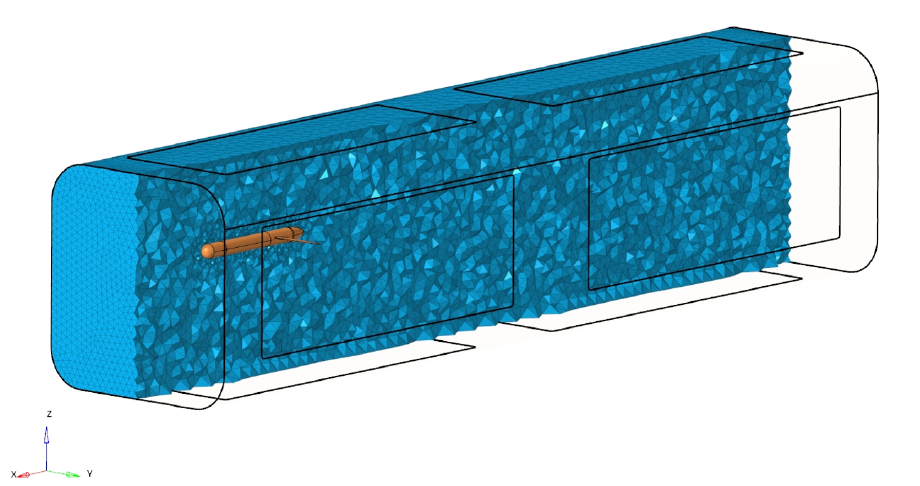
Figure 11. FEM acoustic model of the cavitation tunnel.